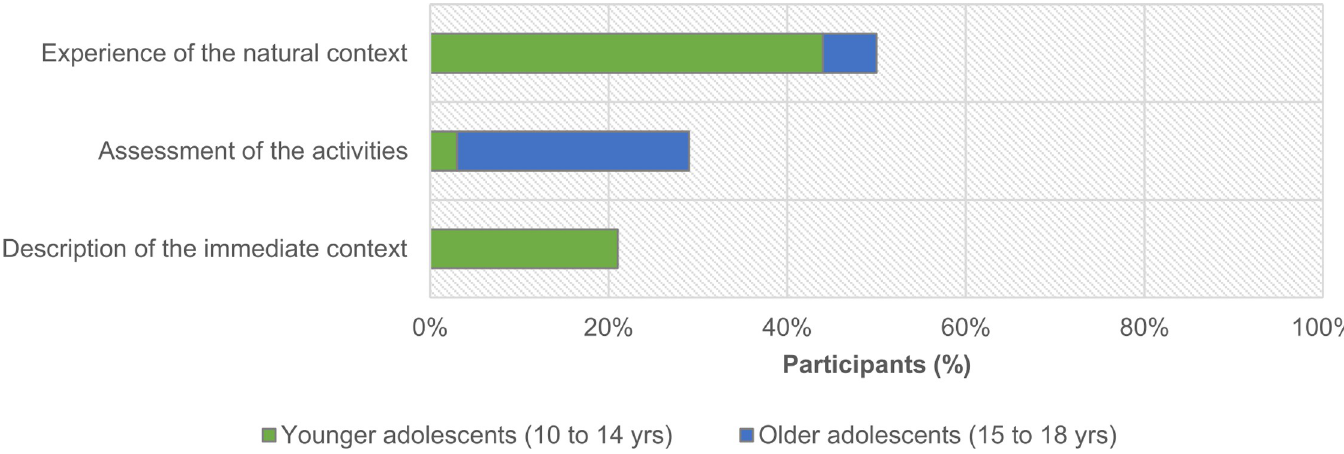
Fig 11. Distribution of participants (n = 34), according to age group, by the dominant theme of their responses to the final free, open-ended activity.